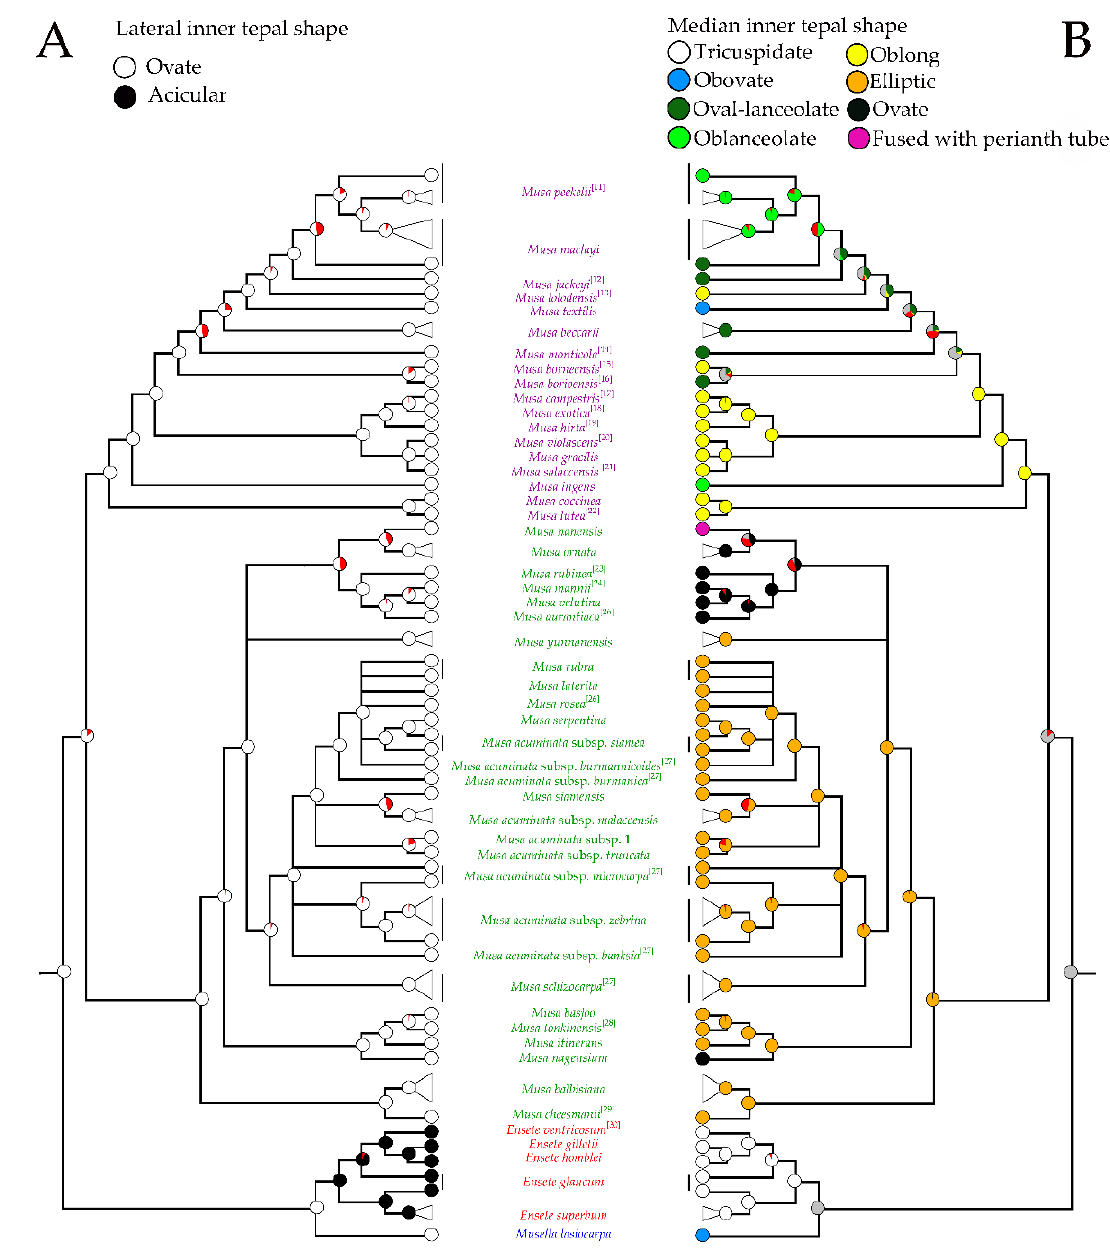
Figure 4. Phylogenetic trees of Musaceae based on the lateral inner tepal shapes ( A ) and the median inner tepal shapes ( B ) of male flower. The trees show ancestral state reconstruction based on Bayesian posterior probabilities of selected morphological states on Bayesian topology constructed from nrDNA and plastid combined data. The tree separated banana clades including Musella (blue font), Ensete (red font), Musa species of sect. Musa (green font) and Musa species of sect. Callimusa (purple font). Circles on nodes show character changes between the taxa, red pies represent node absent and gray pie represent equivocal. Morphological characters from other publications were labeled with reference number